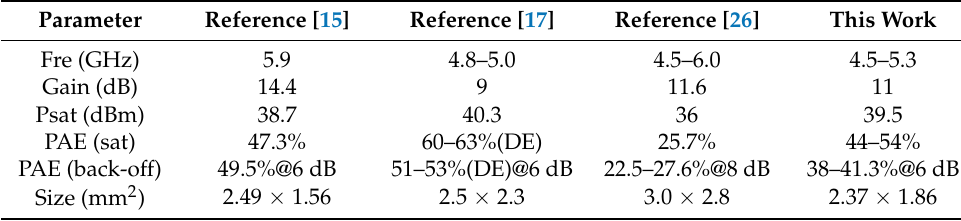
Table 1. Comparison of performance with other published